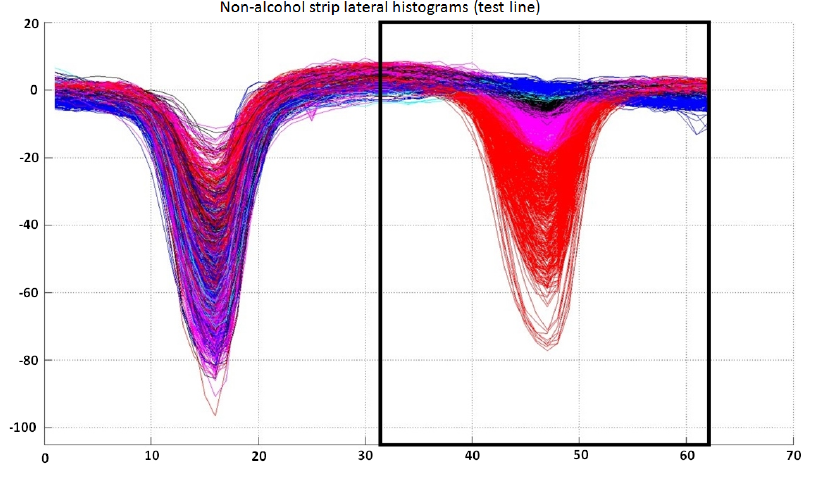
Figure 10. Lateral histogram samples used as training data for the classifier for test lines in non-alcohol strip lateral histograms. Samples labeled as “very negative” are represented in red; “negative” in magenta; “doubtful” in black; “positive” in cyan; and “very positive” in blue. Note that only the last 31 bins of each lateral histogram are used by this classifier.